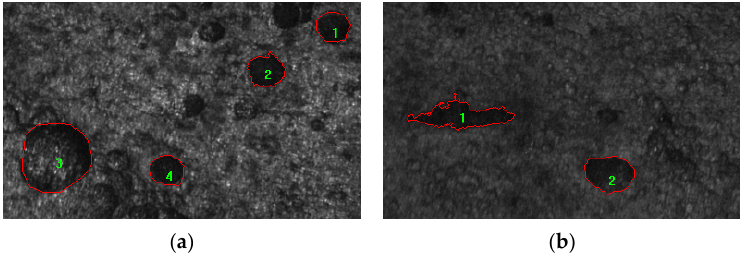
Figure 5. Typical pit patterns for reinforcement under different corrosion conditions: ( a ) RT specimen, AB parameters are 0.74, 0.68, 0.80 and 0.76 for the four pits, respectively; ( b ) RTL specimen, AB parameters are 0.44 and 0.74 for the two pits, respectively.